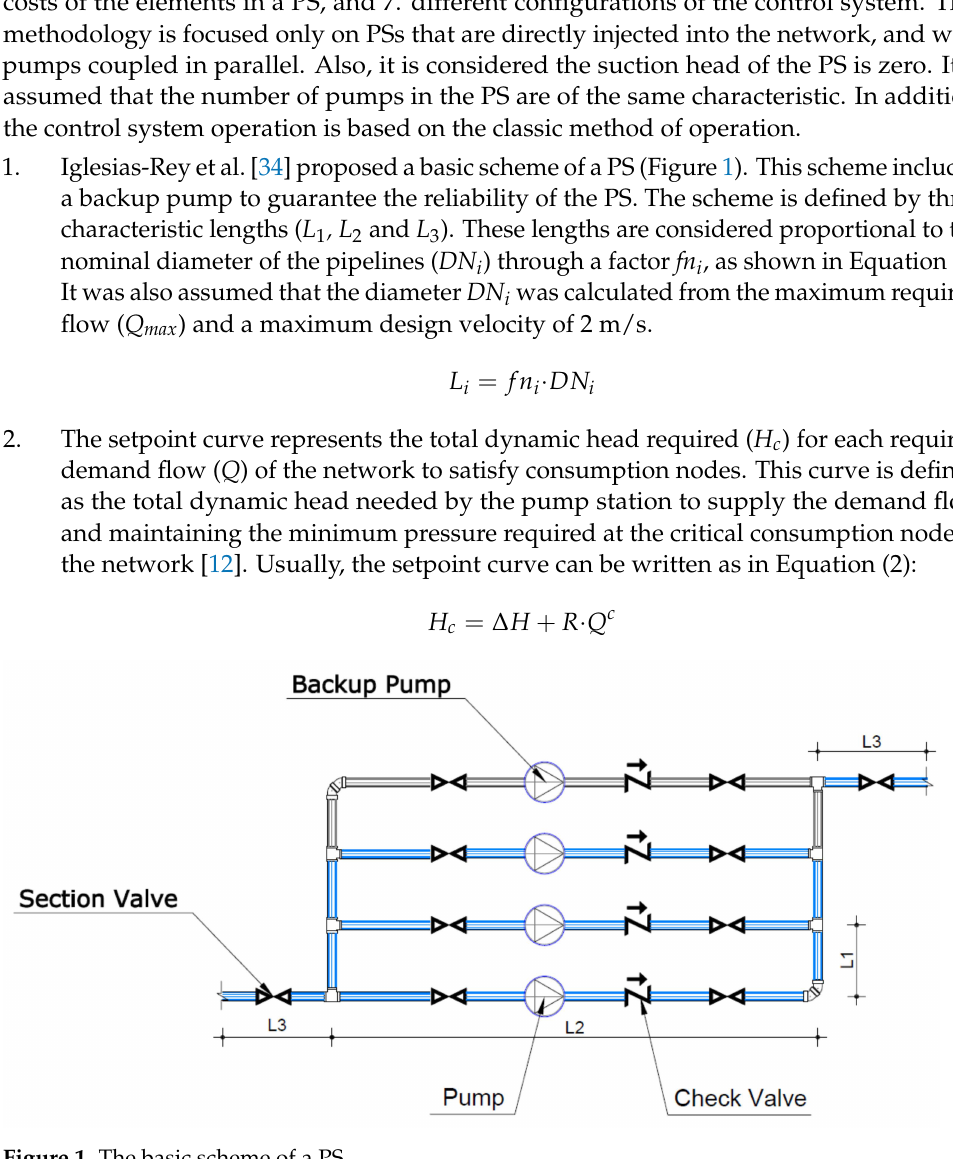
Figure 1. The basic scheme of a